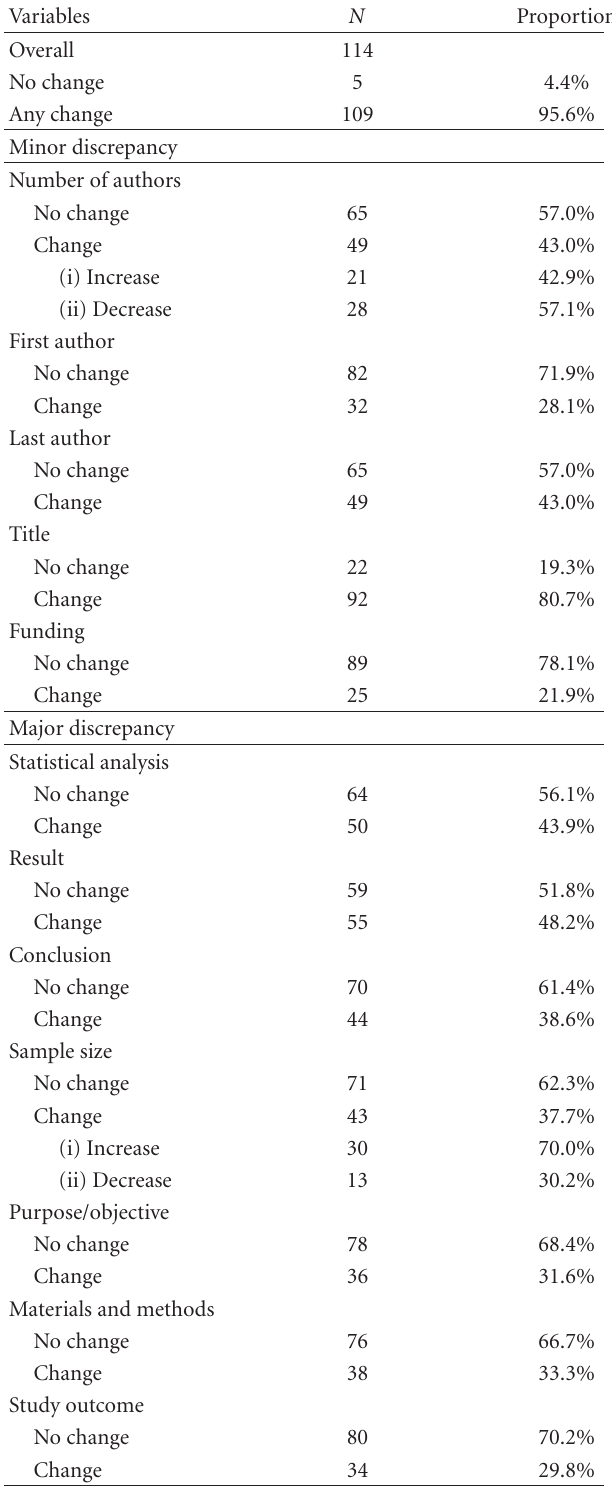
Table 1: Discrepancies between abstracts and their full-text publi-